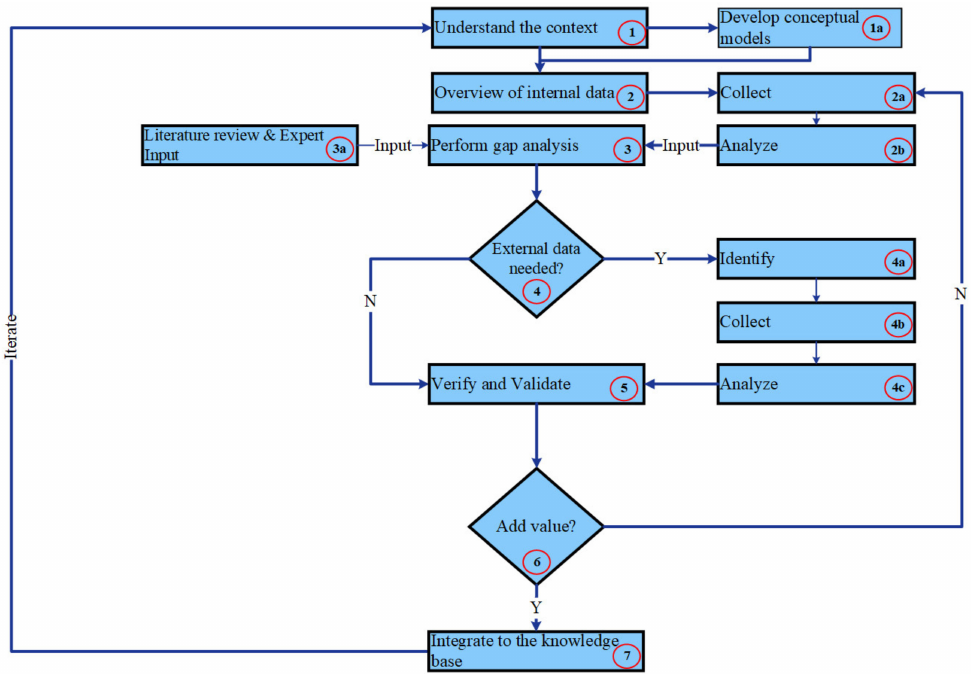
Figure 7. The performed steps visualize the research